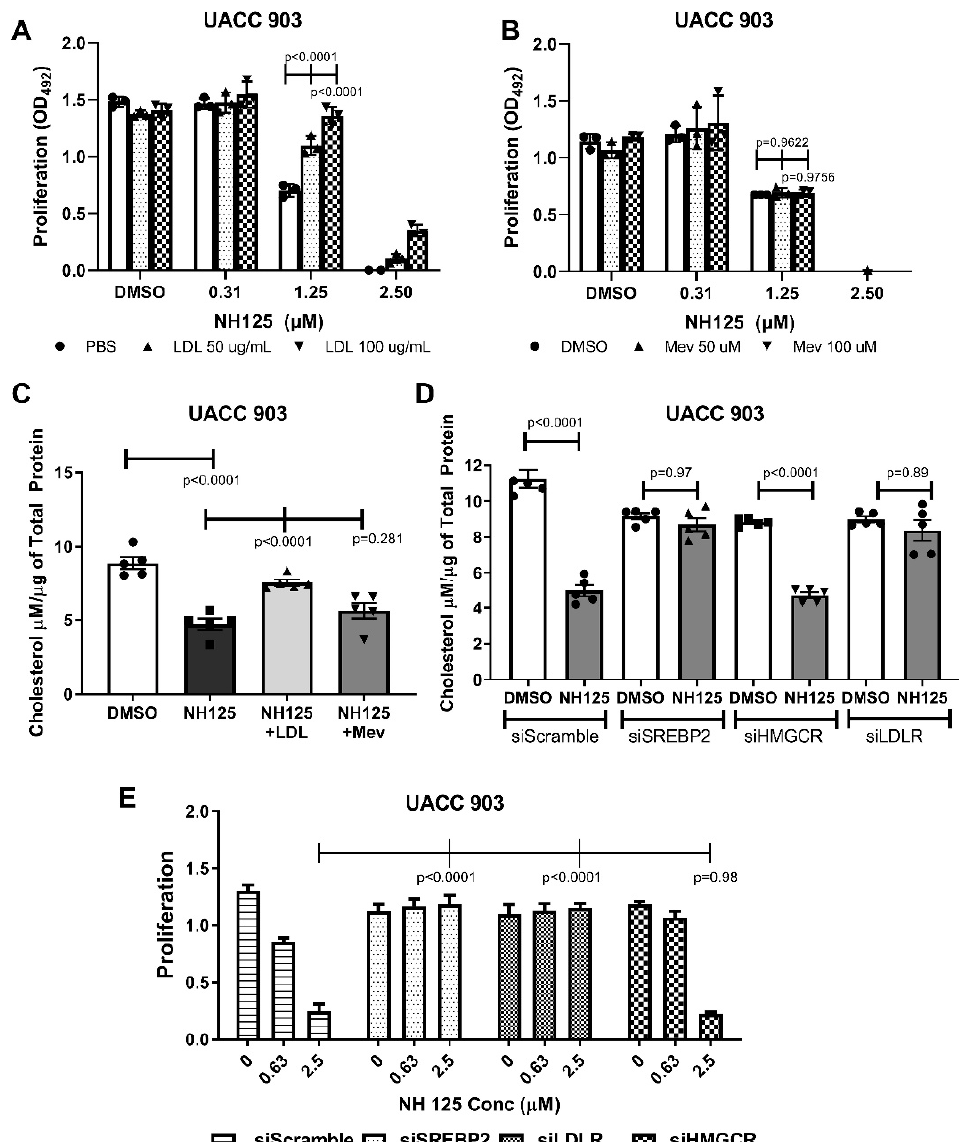
Figure 4. NH125 reduced cholesterol levels through regulation of SREBP2 and LDLR. The effect of NH125 on proliferation of melanoma cells could be completely rescued by addition of LDL ( A ) but addition of mevalonic acid (Mev) had a negligible effect ( B ). Significance was compared PBS/DMSO controls by two-way ANOVA followed by Dunnett’s as post-hoc analysis ( n = 3). Similarly, the reduction of cholesterol levels following treatment with NH125 could be rescued by addition of LDL but not with the addition of mevalonic acid ( C ). Knockdown of SREBP2 and LDLR led to a decreased effect of NH125 on cholesterol levels ( D ) or proliferation ( E ) in UACC 903 melanoma cells. Significance was compared to the respective controls by one-way ANOVA followed by Tuckey’s as post-hoc analysis ( n =